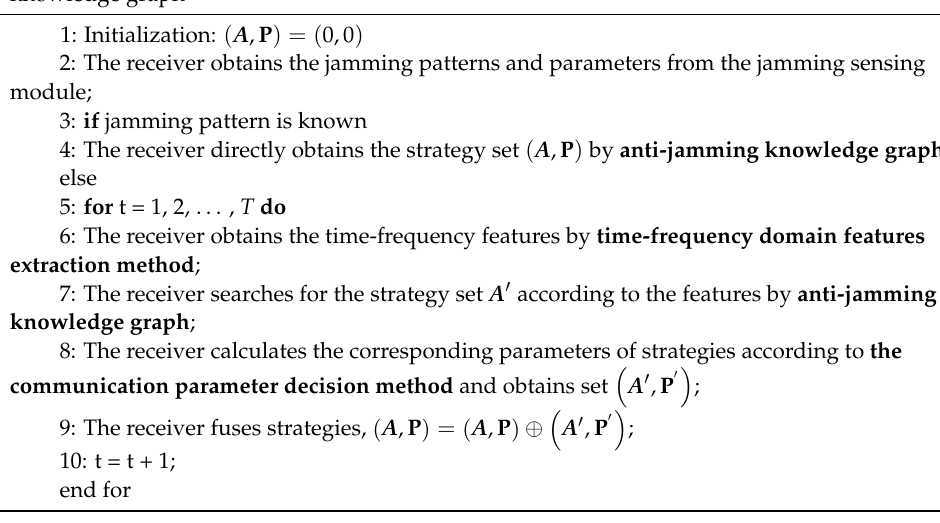
Algorithm 1 Communication anti-jamming decision-making algorithm based on the knowledge